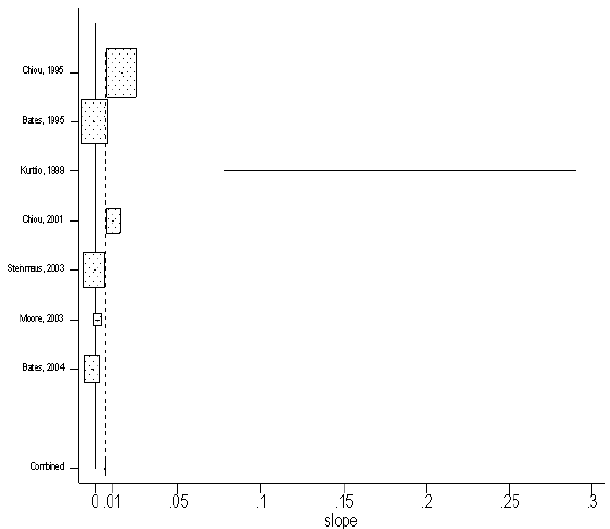
Figure 2: Slope (with the unit of lnRR per unit increase of exposure) of each study and the combined estimate of slope by using fix-effect model. The horizontal line of each study corresponds to its 95% confidence interval, and the size of the square reflects the weight of each